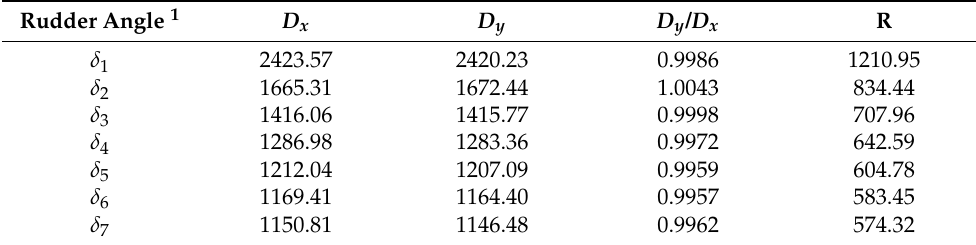
Table 1. Calculation of diameter, ratio, and radius of measured OS trajectory (unit: m).